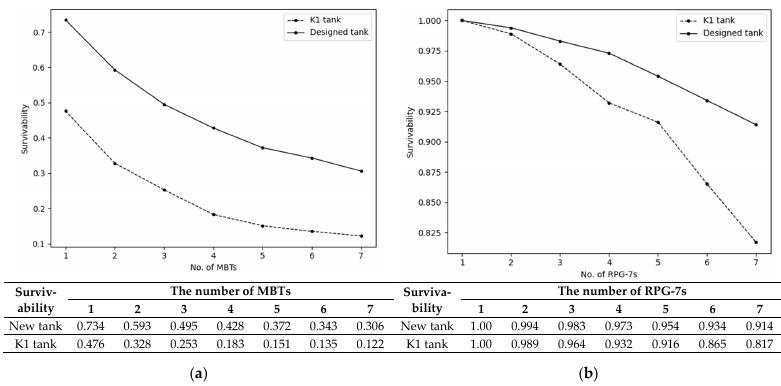
Figure 11. Plots showing the survivability rates. ( a ) Variation of survivability of each MBT model with an increasing number of enemy MBTs; ( b ) variation of survivability of MBT models with an increasing number of anti-tank guns.